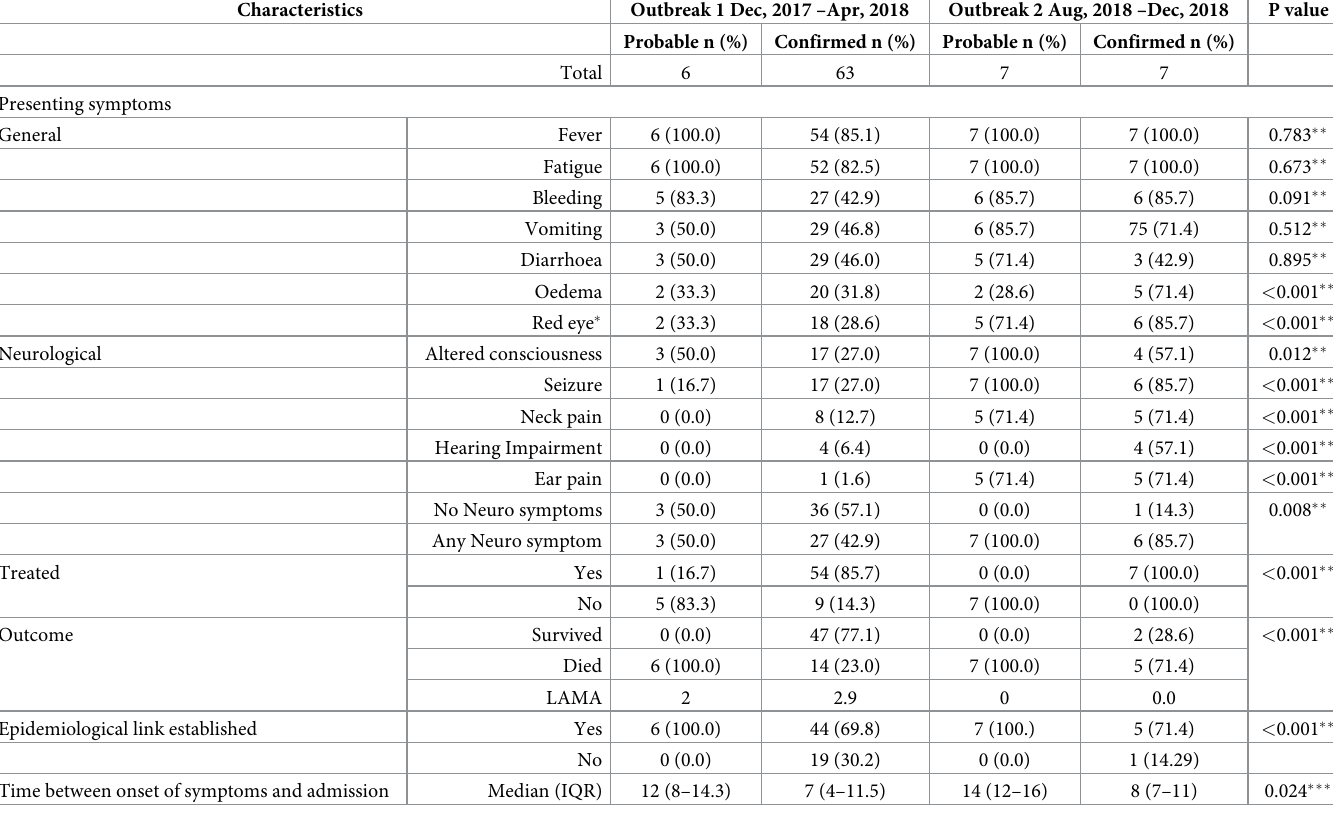
Table 3. Comparison of probable and confirmed cases for each